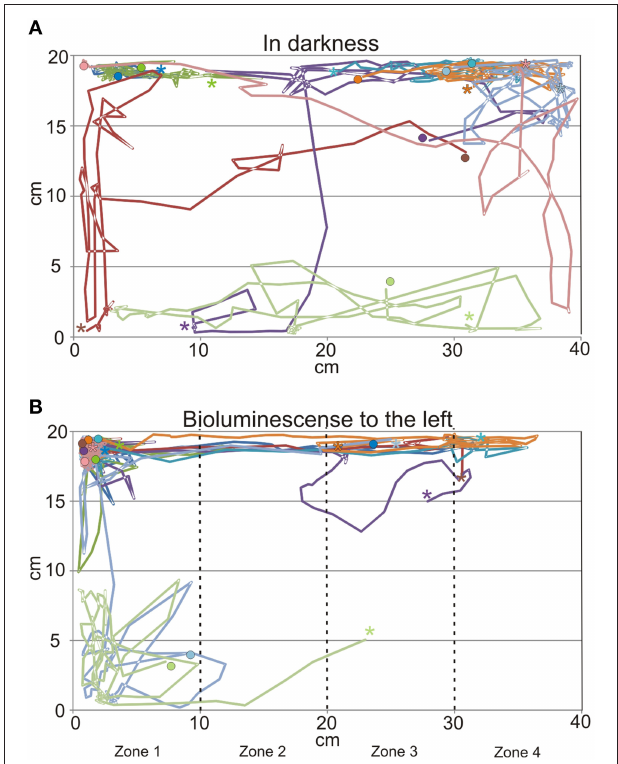
FIGURE 6 | Swim trajectories from behavioral experiments. (A) In darkness the medusae swim in most of the tank but had a preference for the corners of the tank. (B) When the dinoflagellate Pyrocystis noctiluca is emitting bioluminescent light to the left of the tank the medusae spend most of the time in the left side of the tank. Each trace represents 2min with 2s time resolution and each color represents a single medusa ( N = 9). It is the same nine medusae in (A,B) and timewise the trajectories from (A) continues in (B) . See also Figure 7 . Note the parallel run of the blue and green trance in the bottom left where a mating started. * indicates start of trajectory, • end.